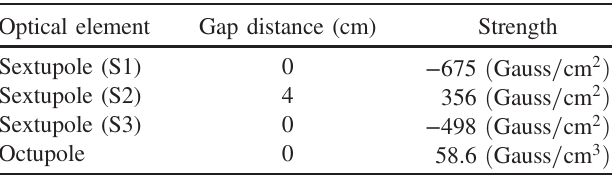
TABLE IV. Aberration correcting elements. See Fig. 1 for location of elements. Gap distance is the spacing between the end of the element and the next downstream element.